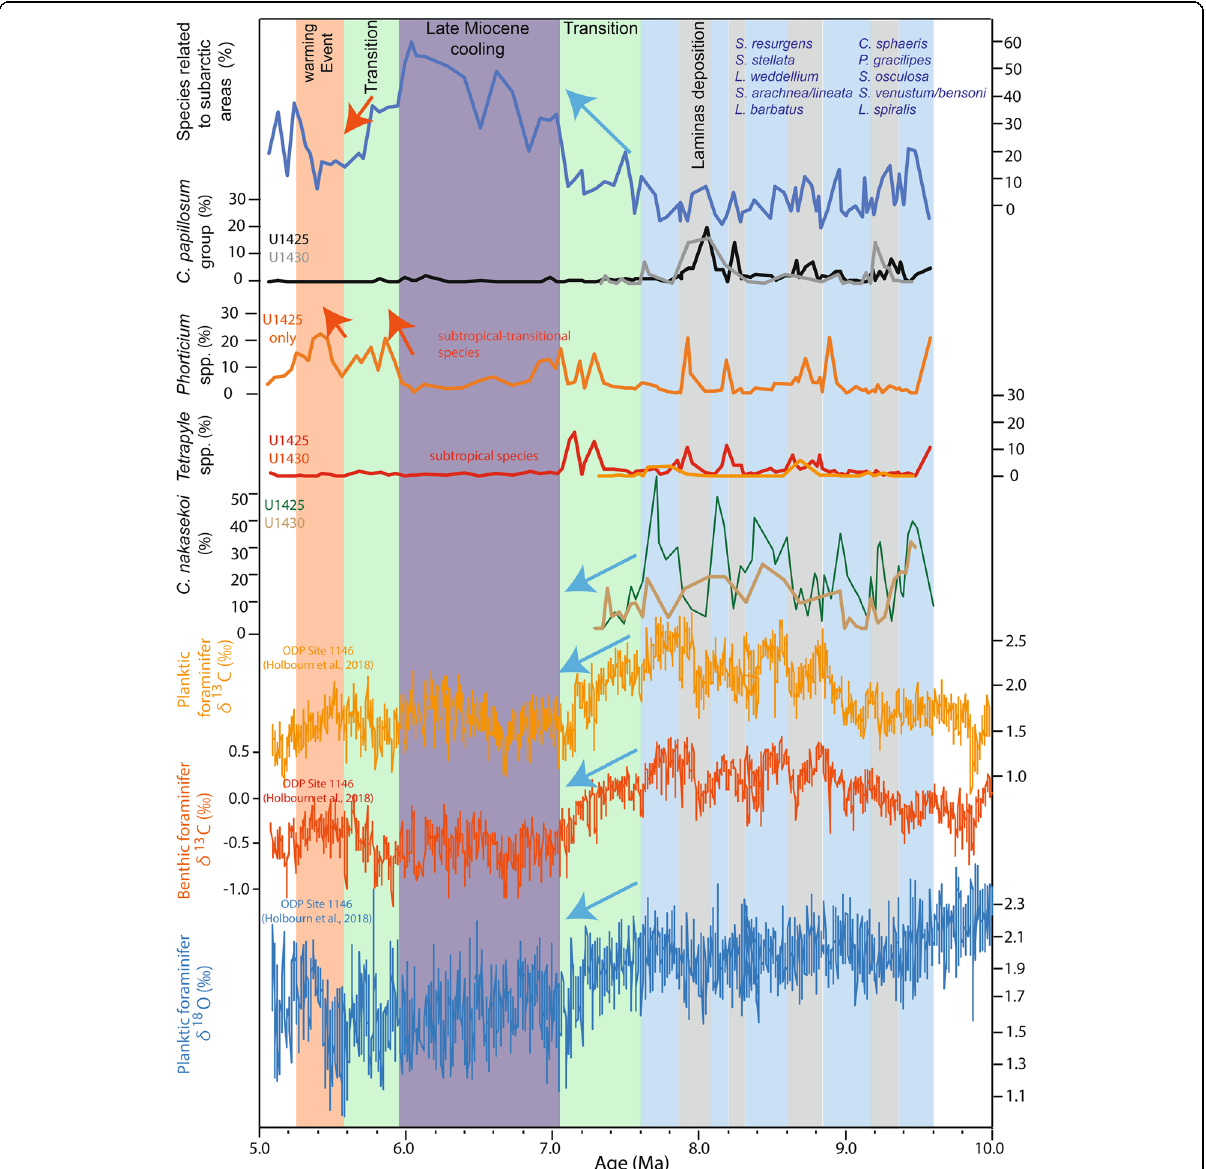
Fig. 6 Details of the late Miocene paleoceanography of the Japan Sea (10 – 5 Ma). We compare relative abundances of C. nakasekoi , Tetrapyle spp., and C. papillosum from Sites U1425 and U1430 between 9.5 and 7 Ma. The interval between 7.0 and 5.0 Ma shows relative abundance of Phorticium spp. and species related to subarctic water (the selected species are listed at the upper right in the figure). These data are compared to oxygen and carbon isotope data for planktic and benthic foraminifer obtained from the South China Sea (ODP 1146, Holbourn et al.